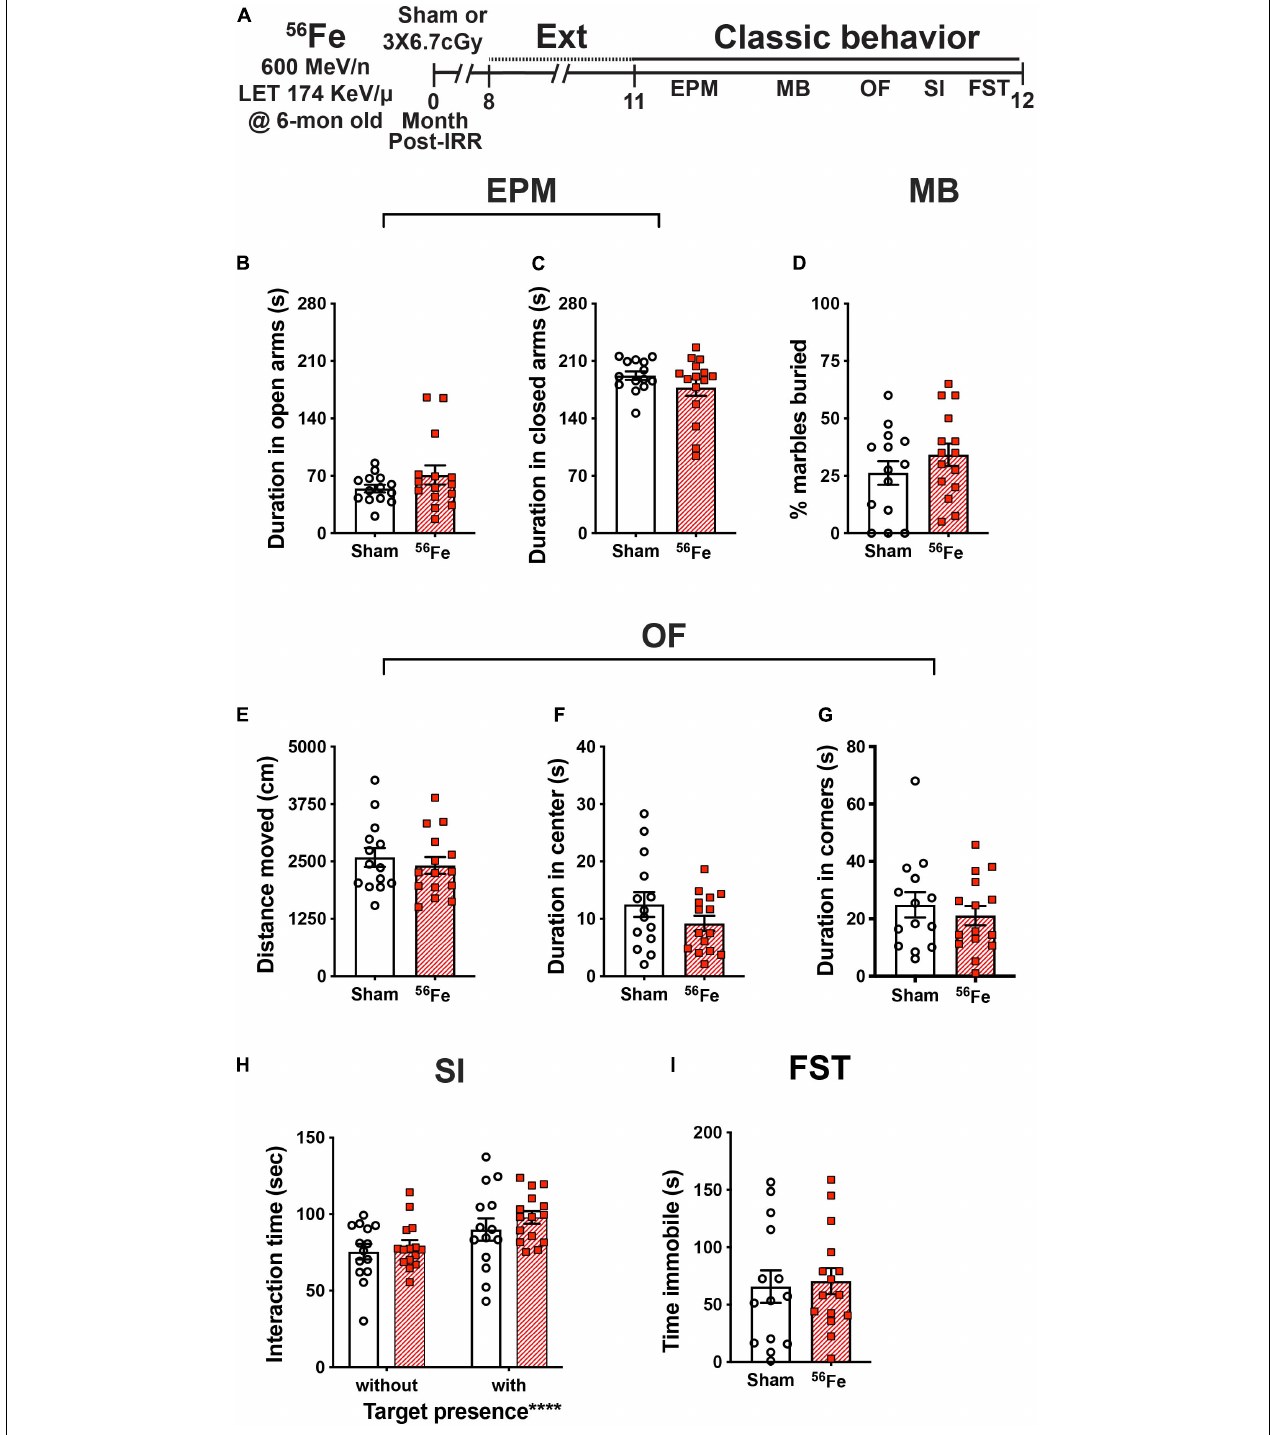
FIGURE 6 | Timeline and results of classical behavior tests show anxiety-, compulsive-like behavior, and despair-like behavior and sociability are generally unaffected in female mice exposed to whole-body 56 Fe IRR at 6-mon-old compared to Sham. (A) Six-month old C57BL/6J female mice that received whole-body exposure to 56 Fe [0-Month Post-Irradiation (IRR)] and finished touchscreen LDR and Ext were then run on a variety of non-touchscreen classic behavioral tests. (B,C) Sham and 56 Fe IRR mice showed no difference in anxiety-like behavior as shown by the time spent in either the open arms (B) or closed arms (C) of the elevated plus maze (EPM). (D) Sham and 56 Fe IRR mice showed no difference in compulsive-like behavior as shown by percent of marbles buried in the marble burying (MB) task. (E–G)